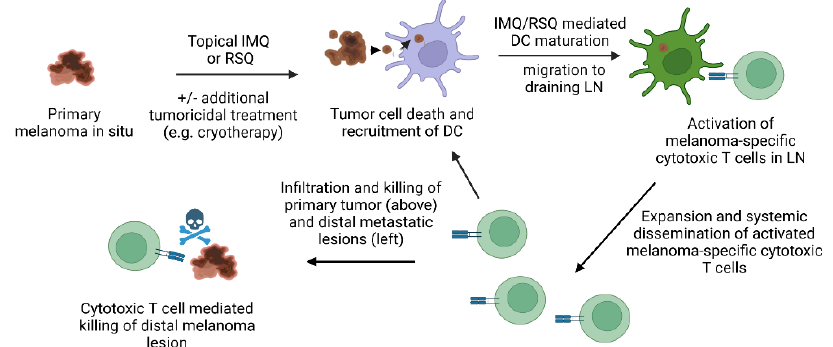
Figure 3. Proposed mechanism of action of IMQ/RSQ in treating melanoma. Topical treatment of in situ melanoma lesion (e.g., primary lesion) plus/minus another form of treatment (e.g., cryotherapy, ultrasound, or melanoma vaccine) leads to tumor cell death and IMQ/RSQ mediated infiltration (through TLR-mediated production of inflammatory cytokines; not shown) and activation/maturation of DC (e.g., by TLR-mediated upregulation of costimulatory molecules on the surface of DC; not shown). These DC can take up antigenic material from the dying/dead melanoma cells, travel to the draining lymph node (LN) and activate melanoma-specific cytotoxic T cell responses by presenting melanoma antigens in the context of MHC class I (not shown), likely with the aid of helper T cells (not shown). Activated melanoma-specific cytotoxic T cells then travel to cites of melanoma lesions (primary and/or metastatic lesions) that possess an inflammatory phenotype, where they can specifically recognize and kill the tumor cells. Purple cell with brown fragment = recruited immature DC haven taken up tumor cell debris/antigen; green cell with brown fragment = activated/mature DC containing tumor cell debris/antigen; round green cells with blue receptors = melanoma-specific cytotoxic T cells + T cell receptor/TCR.